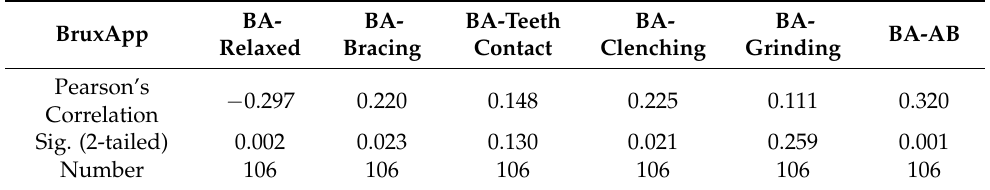
Table 1. Correlations between awake bruxism (AB) as defined by single-point self-report and BruxApp conditions.